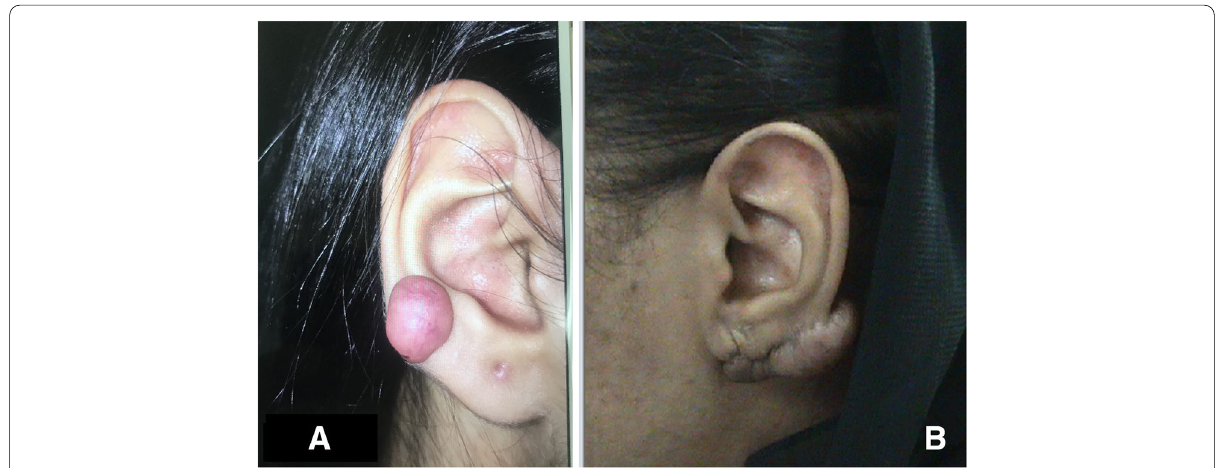
Fig. 1 Patients with recurrent ear keloids of different sizes. A Showed patient with RT ear keloid less than 2 cm. B Showed patient with left ear keloid more than 2